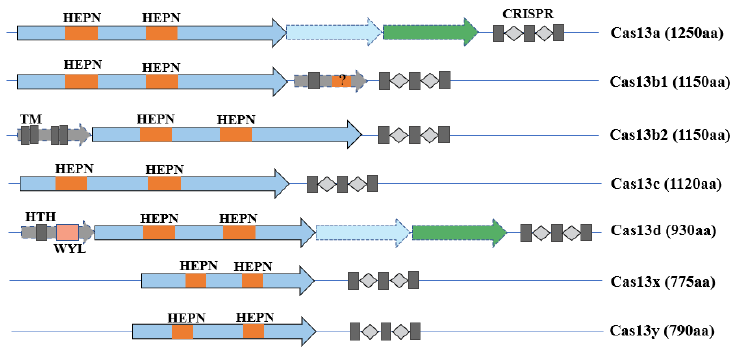
Figure 1. Constitutions of different Cas13 subtypes.